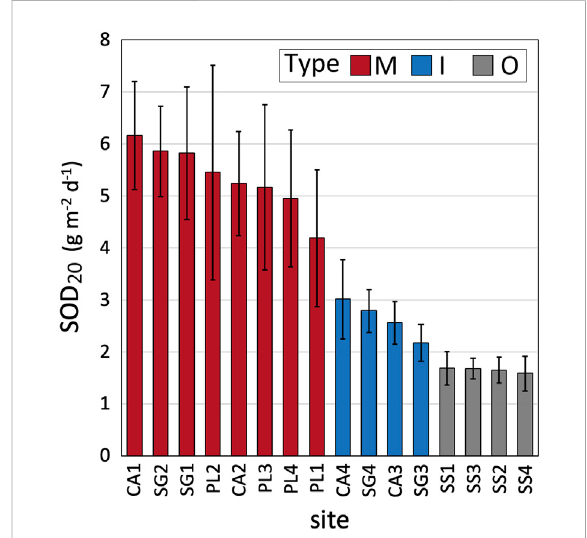
FIGURE 6 Mean SOD 20 rate for the whole period in the 16 sites, in increasing order; the line indicates the standard deviation value. Bar coloring highlights the three types of sites.